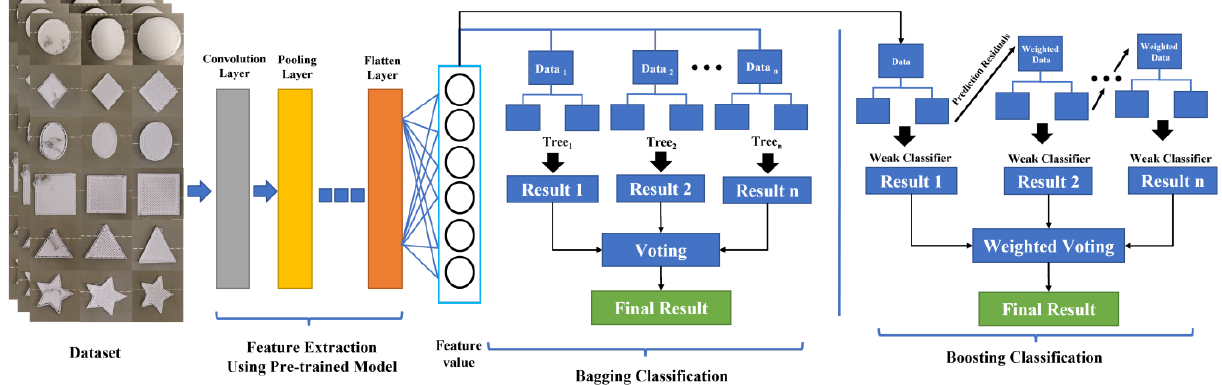
Figure 4. The flow graph of the proposed method for bagging or boosting classification.